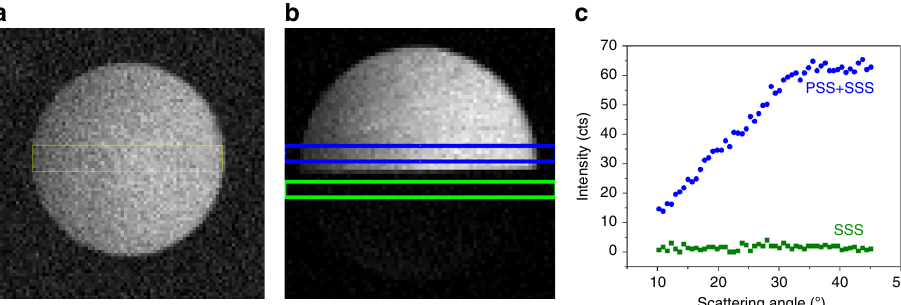
Fig. 2 Angle-resolved second harmonic scattering patterns obtained through Fourier imaging. a Image of the angle-resolved second harmonic scattering (AR-SHS) scattering pattern for 320 nm polystyrene beads coated with malachite green, b Image of the AR-SHS scattering pattern for 320 nm polystyrene beads coated with malachite green with insertion of a polarizing sheet along the S-polarization direction) in the lower half of the back focal plane. By symmetry considerations the SSS signal (i.e., both the incident and detected light along the S-polarization direction) originating from the surface of polystyrene beads coated with malachite green vanishes 60 , which is why the bottom half of the image appears dark. The blue and green areas depict the regions of interest analyzed in Fig. 2c. c Graphs of selected areas render AR-SHS for different polarization combinations simultaneously: blue no polarizing sheet, PSS (i.e., incident light along the S-polarization direction and detected light along the P-polarization direction) + SSS; green polarizing sheet: